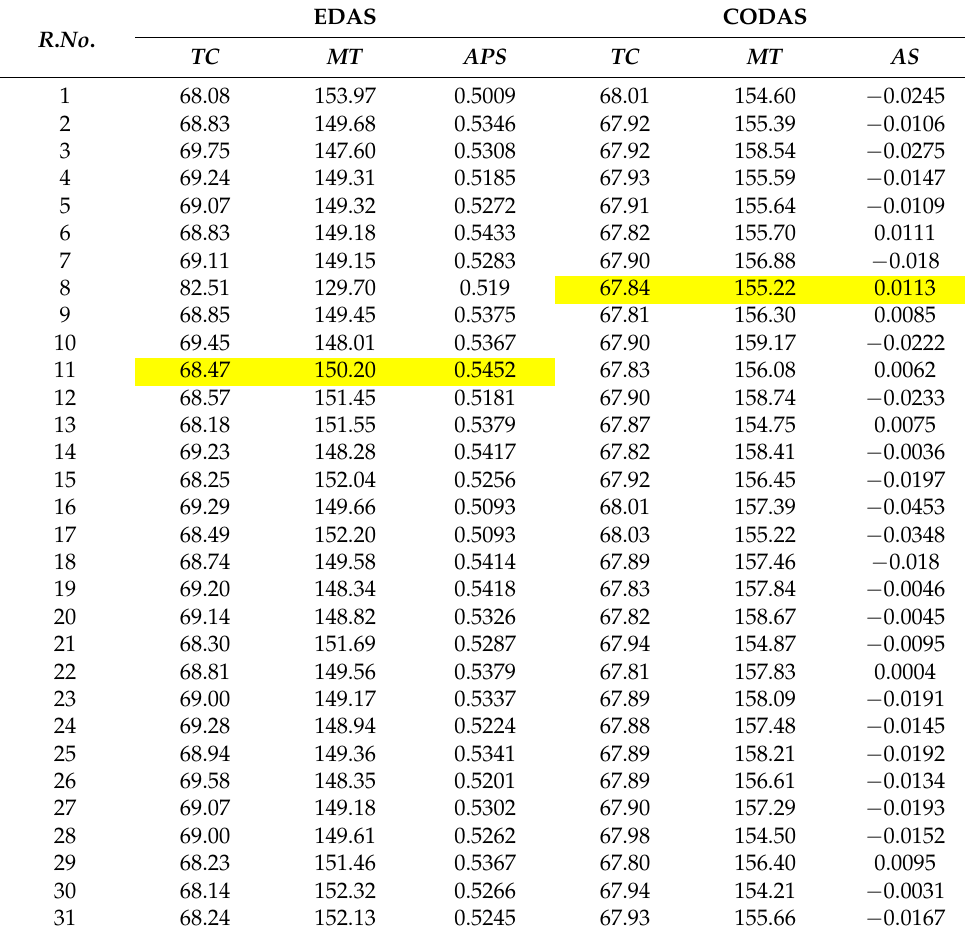
Table 11. Appraisal (APS) and assessment (AS) scores of EDAS and CODAS. R . No .